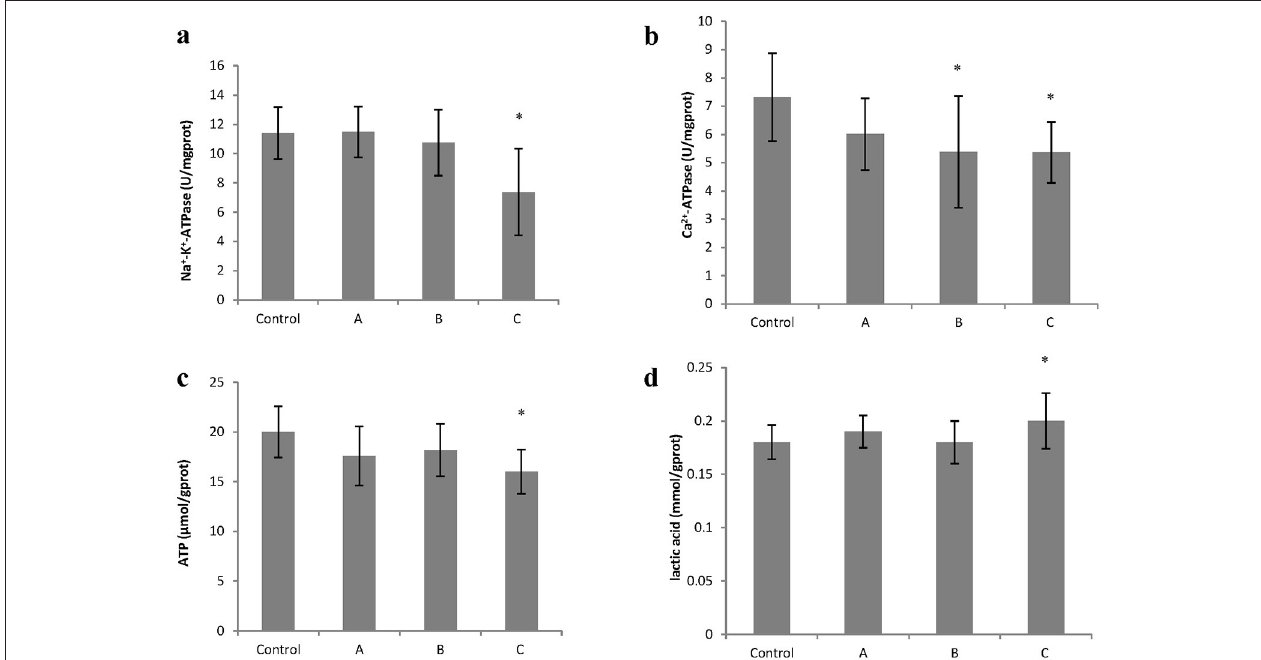
FIGURE 1 | Changes in Na +− K + -ATPase and Ca 2 + -ATPase activity, ATP and lactic acid content in mouse brain cells induced by subacute poisoning of 1,2-DCE. (a) Comparison of Na + -K + -ATPase activity in mouse brain cells among groups; (b) Comparison of Ca 2 + -ATPase activity in mouse brain cells among groups; (c) Comparison of ATP content in mouse brain among groups. (d) Comparison of lactic acid level in mouse brain among groups. The number of mice were 10 in control group, 9 in group A, 8 in group B, and 8 in group C. Data were given as mean ± SD , and analyzed by One-way ANOVA. Significant difference was defined as P < 0.05. * vs. control group.